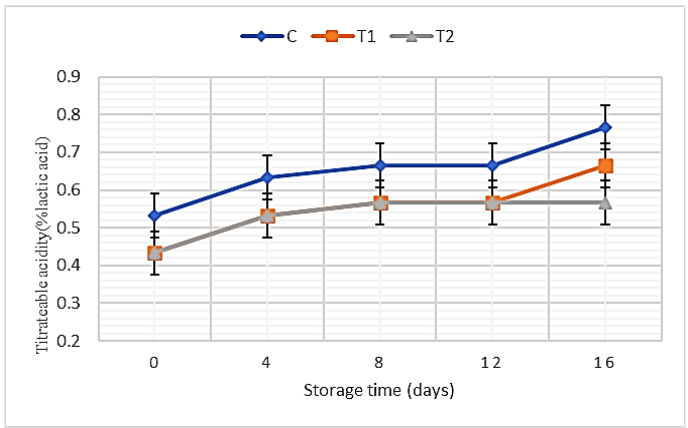
Figure 2. Acidity percentages of SLY samples without and with REO addition during storage up to 16 days.